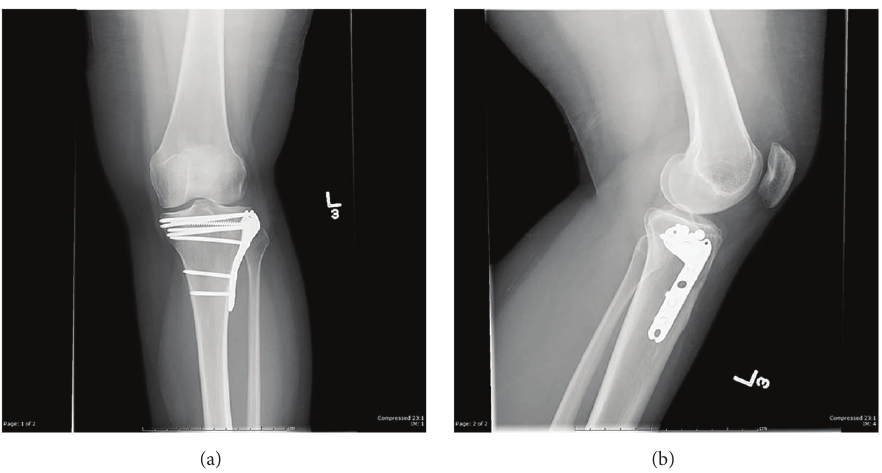
Figure 5: AP and lateral plain radiographs at sixteen months